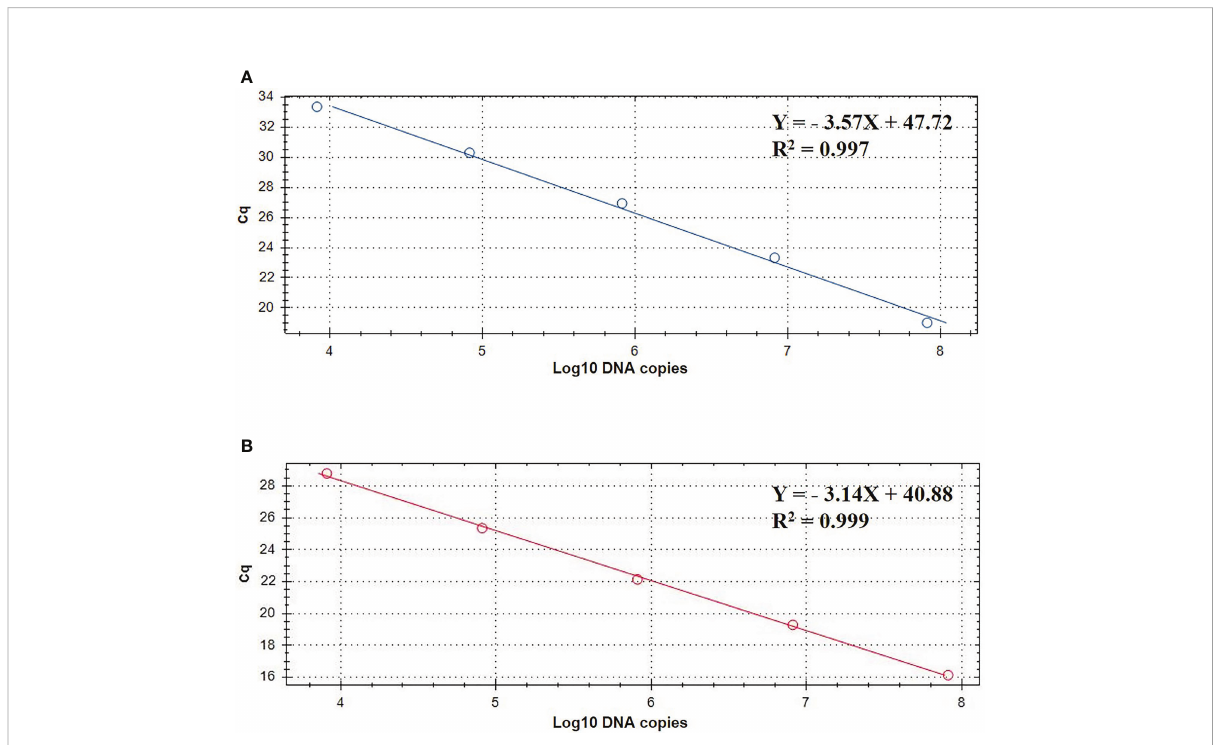
FIGURE 2 TaqMan standard curve of 10- fold dilutions of linearized plasmids pMD-gdh (A) and pMD-apxIVA (B) ranging from 10 3 to 10 7 DNA